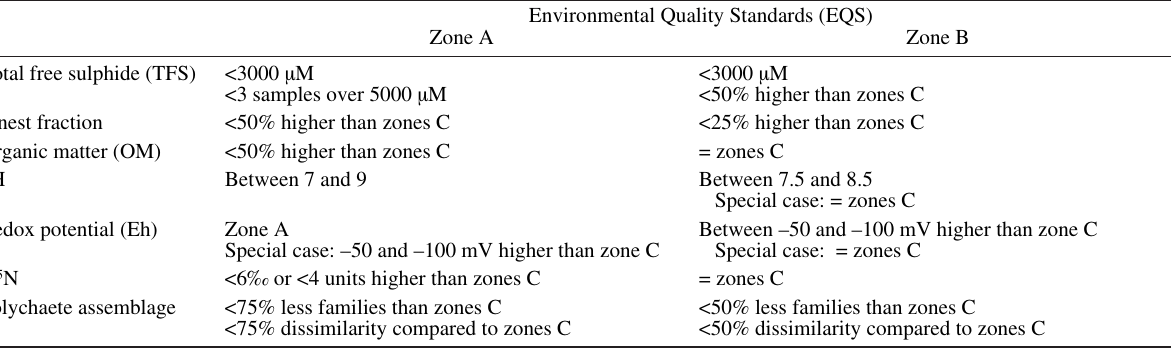
Table 1. – Summary of the environmental quality standards (EQS) proposed by the JACUMAR EMP. Zone A, inside the perimeter of the lease-hold area physically below the facilities; zone B, area surrounding the administrative concession, no more than 50 m outside the